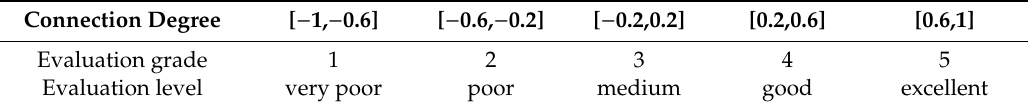
Table 8. The grading of evaluation results corresponding to the connection